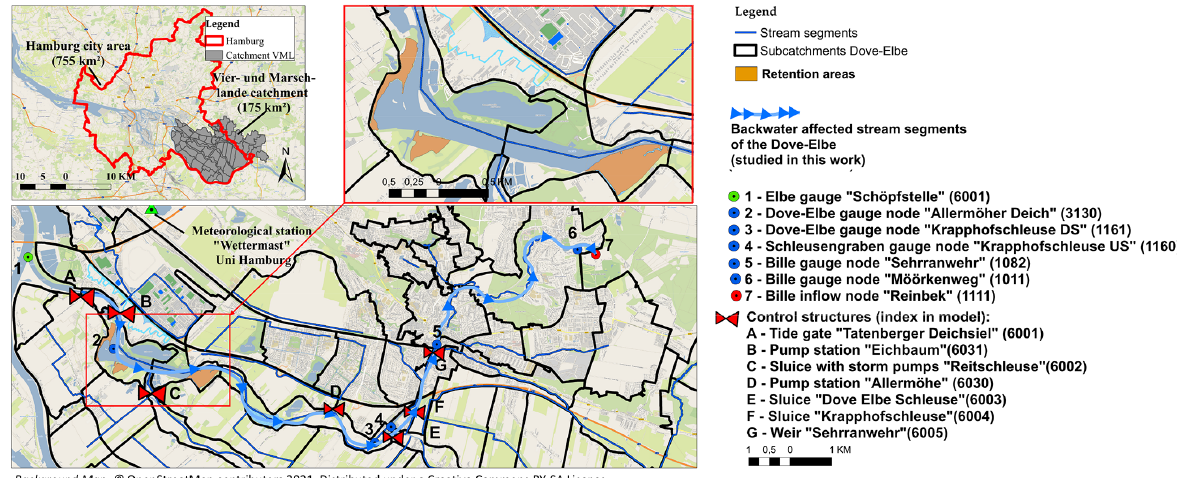
Figure 10. Map of the application study area Vier- und Marschlande (175km 2 ): sub-catchments, gauging stations (1 to 7), studied backwater- affected streams of the Dove–Elbe, three retention areas in the main stream and control structures (A to